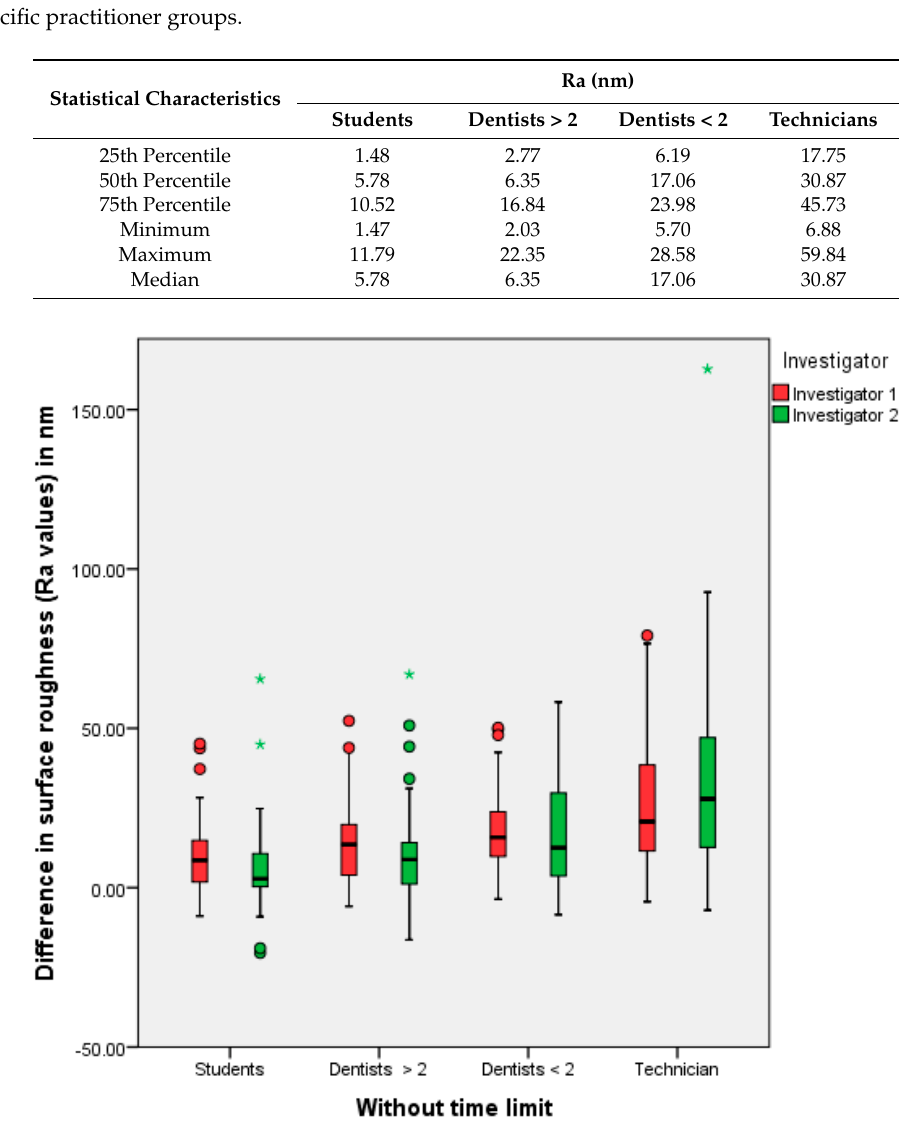
Figure 1. The polishing results (=differences between the Ra values before and after polishing) of the different practitioner groups, investigators one and two/first trial (* extreme values, • outliers).